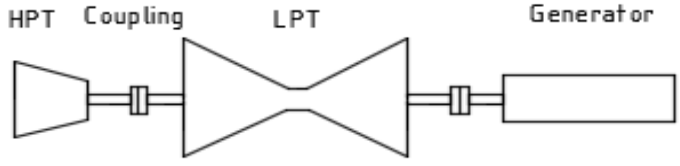
Figure 1. T/G with one (1) LPT cylinder.